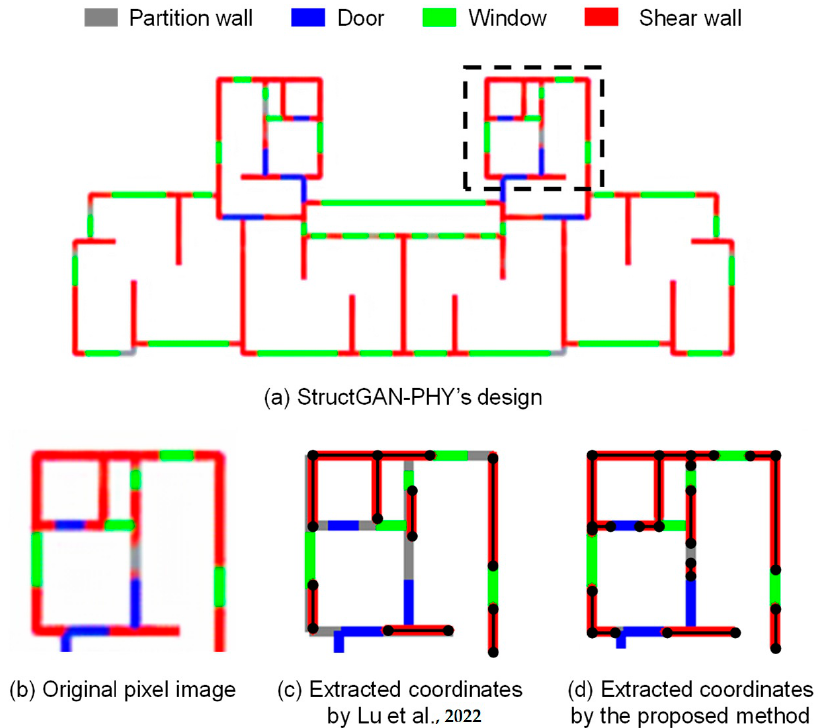
Figure 11. Comparison between different heterogeneous data transformation methods [14].